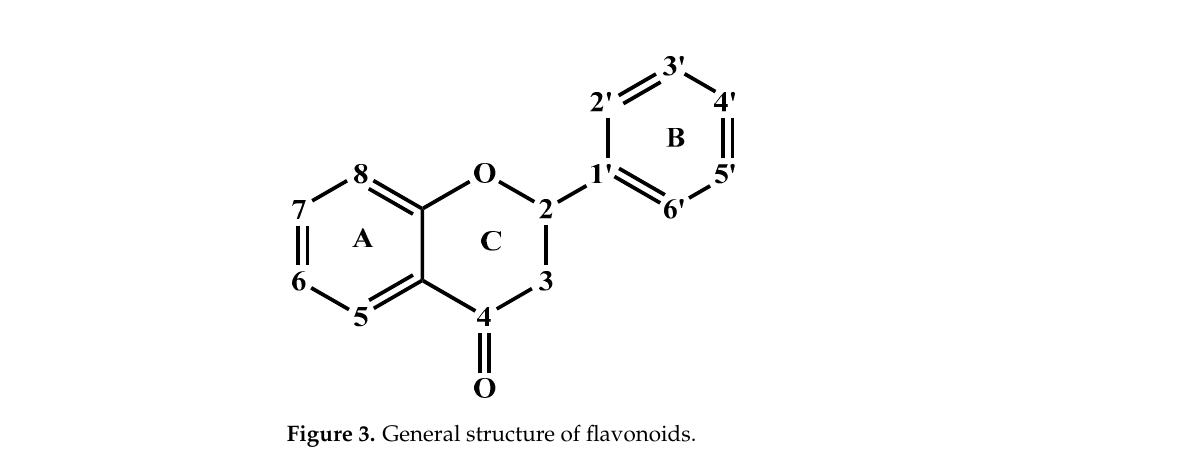
Figure 3. General structure of flavonoids. Table 3. Minimum inhibitory concentration (MIC) and minimum bactericidal concentration (MBC) of the Hypericum species against E. coli , S. enteritidis , S. aureus , and E. faecalis